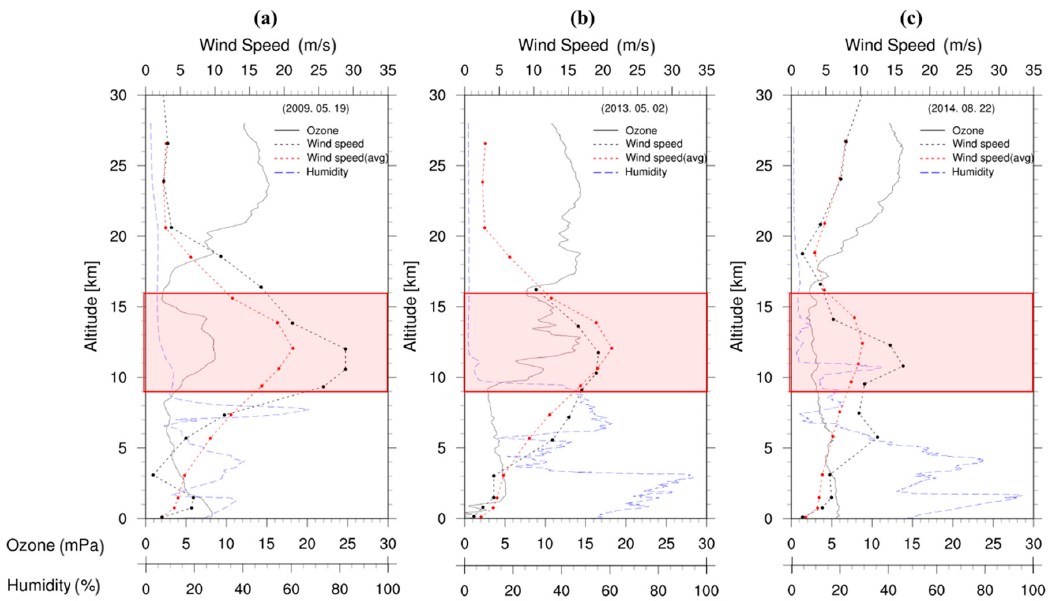
Figure 7. Vertical profile of ozone partial pressure and air temperature on ( a ) 19 May 2009, ( b ) 2 May 2013, and ( c ) 22 August 2014, respectively. The shaded area represents the second ozone peak layer.